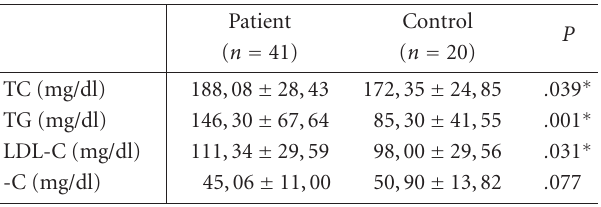
Table 4: Plasma lipids and lipoproteins in patients with psoriasis and control subjects for males.